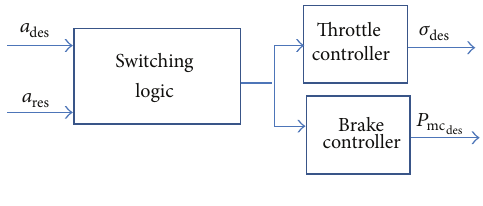
Figure 5: Low level